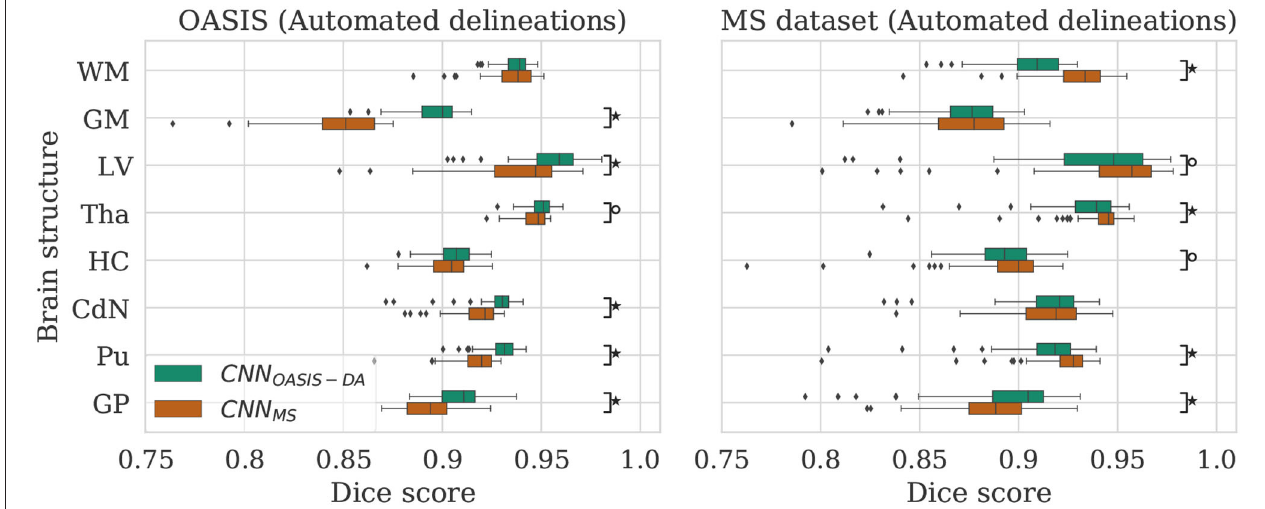
FIGURE 5 | Dice scores for the CNN OASIS - DA and CNN MS models on the OASIS (left) and MS dataset (right) test sets. Marks indicate that there is a significant difference between the two models (Wilcoxon, ◦ p < 0.05, ⋆ p < 5 × 10 − 4